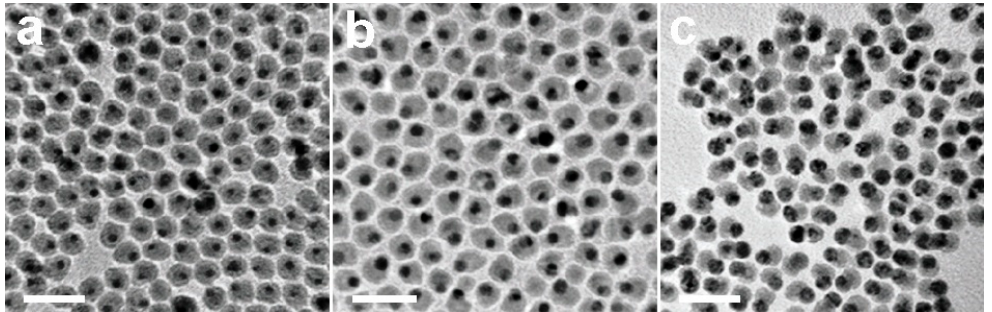
Figure 1. Transmission electron microscopy (TEM) images of Fe-Au heterodimers with different particles sizes. 15–4 nm Fe-Au heterodimers ( a ), 7–13 nm Fe-Au heterodimers ( b ), and 11–10 nm Fe-Au heterodimers ( c ), scale bars: 50 nm. Reproduced with permission from [81], copyright (2016) Royal Society of Chemistry.